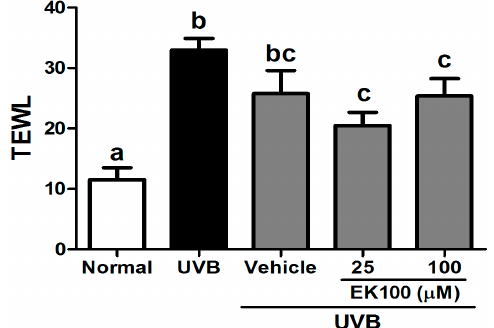
Figure 3. Effect of EK100 on the TEWL in UVB-irradiated hairless mice in the 10th week. UVB exposure significantly increased the TEWL in the mouse skin; however, the topical application of 25- μ M and 100- μ M EK100 in the mice significantly reduced the TEWL. a–c : Values not followed by a common letter are significantly different ( p < 0.05).